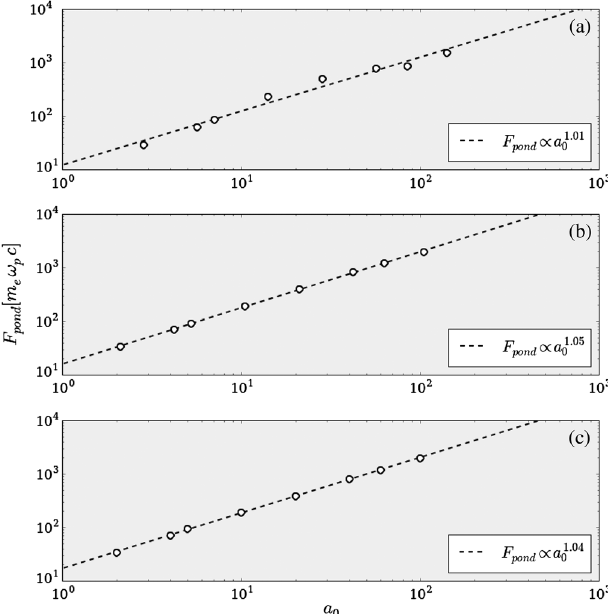
FIG. 3. Log-log plots of max ponderomotive force against electromagnetic wave intensity for differing mass ratios ¼ 1 , (b) m i ¼ 100 , and (c) m i ¼ 1836 . The ponderomotive (a) m i m e m e m e force scales linearly with a 0 , independent of the mass ratio.